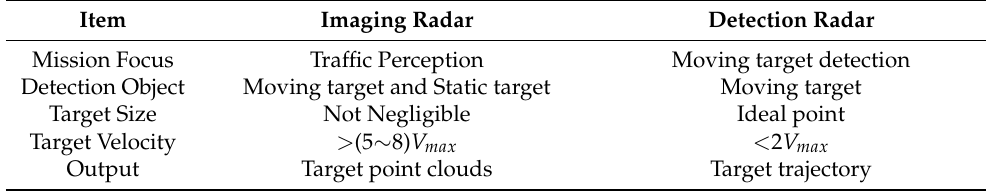
Table 2. Imaging radar vs. detection radar.